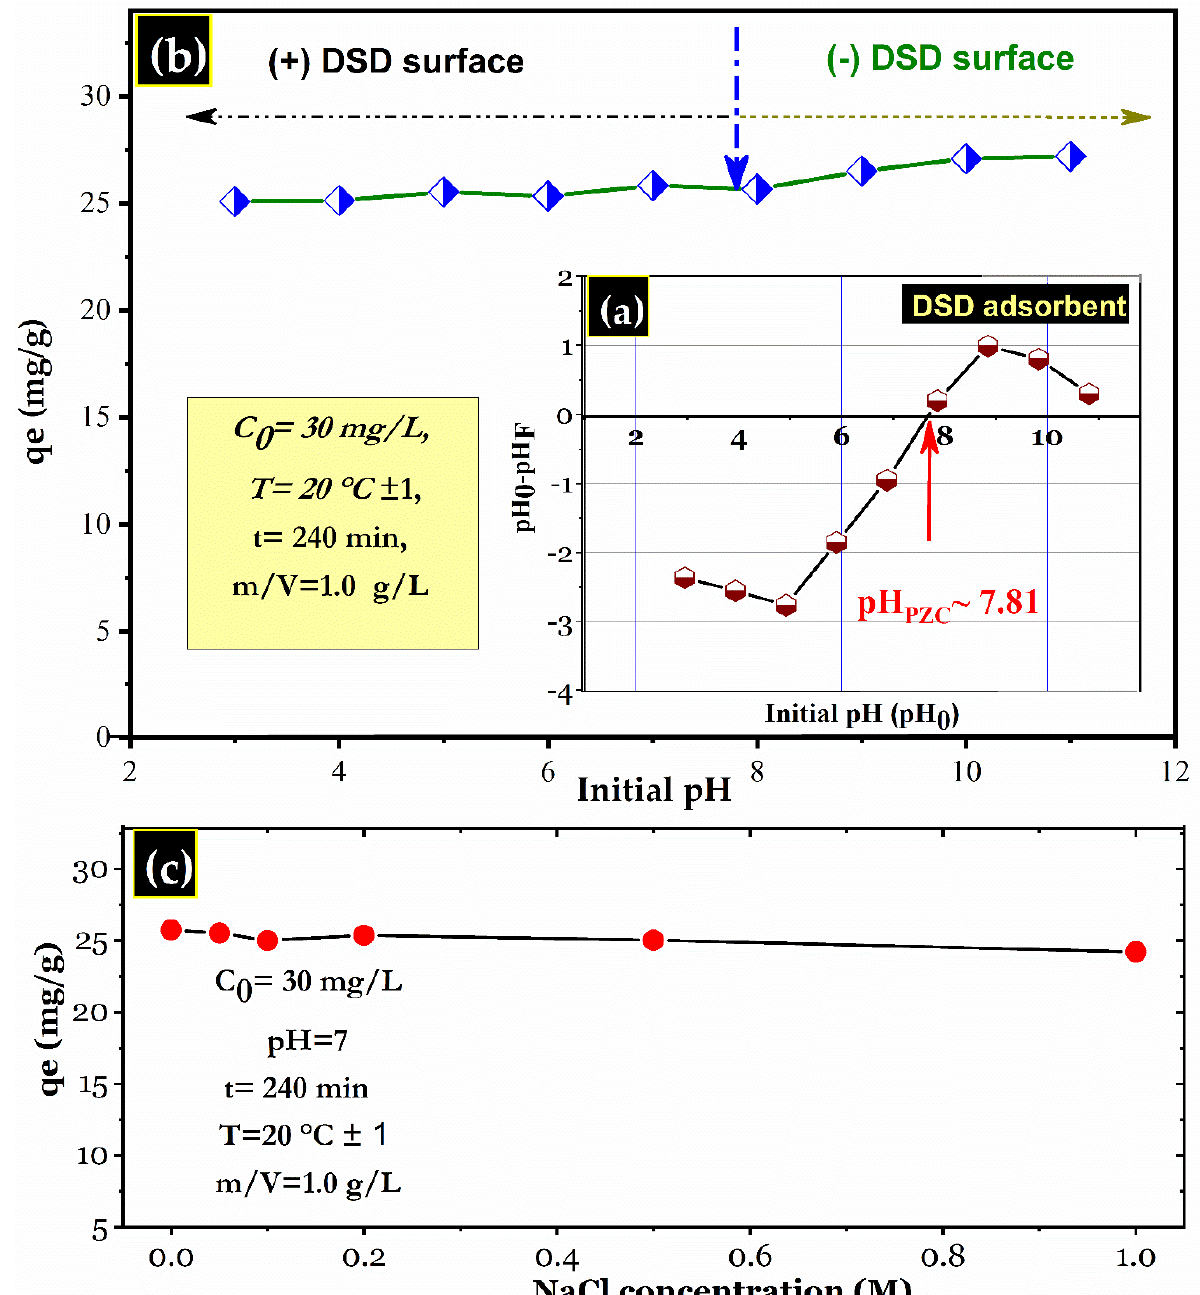
Figure 4. ( a ) pH PZC of DSD sample; effect of ( b ) initial pH value and ( c ) ionic strength on the adsorption capacity of DSD Figure 4. (a) pH PZC of DSD sample; effect of (b) initial pH value and (c) ionic strength on the adsorbent to crystal violet adsorption capacity of DSD adsorbent to crystal violet dye.